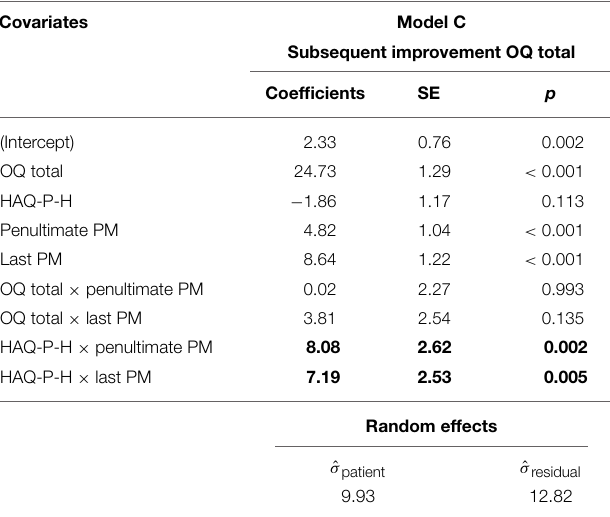
TABLE 4 | Prediction of the subsequent improvement using a mixed model based on process measurements (PM). Covariates Model